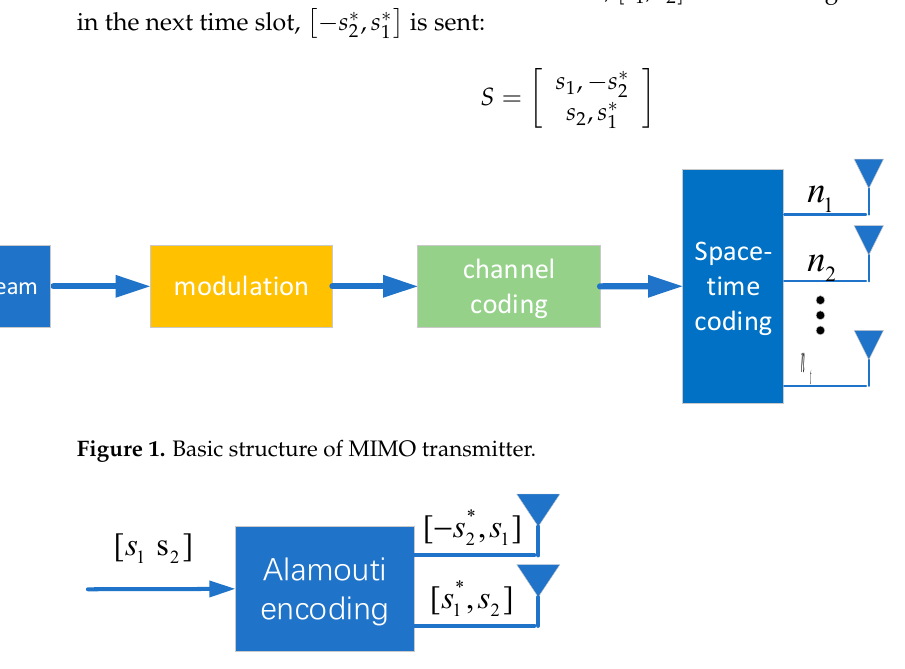
Figure 2. Alamouti space-time coding principle.